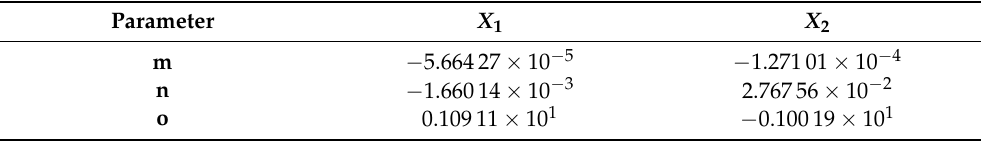
Table 5. Generalised parameters to compensate for temperature distortion in energy spectrum measurement accuracy using Timepix3 detectors with 500µm Silicon